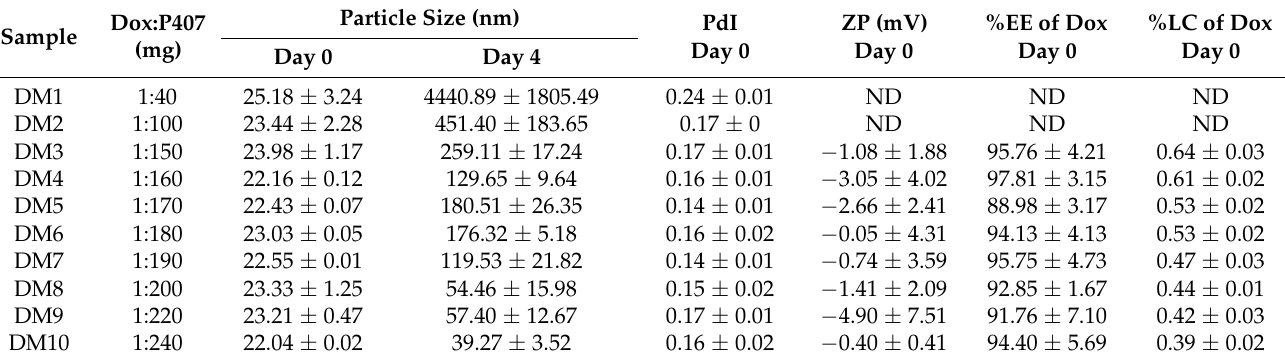
Table 1. Particle size, polydispersity index (PdI), zeta potential (ZP), and %entrapment efficacy (EE) of various formulations of DM on day 0 and particle size on day 4 at RT ( n = 3, mean ±